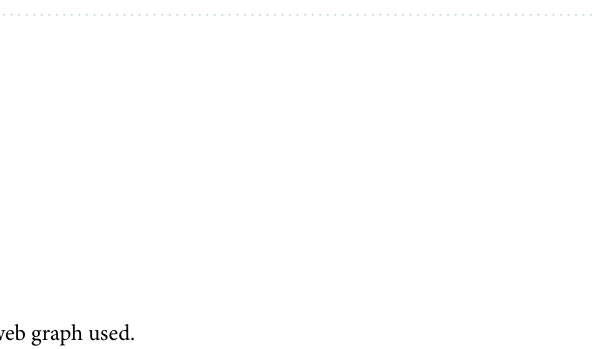
Figure 3. Descriptive statistics of the Reddit dataset. Subfigures ( a ) and ( b ) show raw values, subfigures ( c ) and ( d ) show the complement of the cumulative distribution.